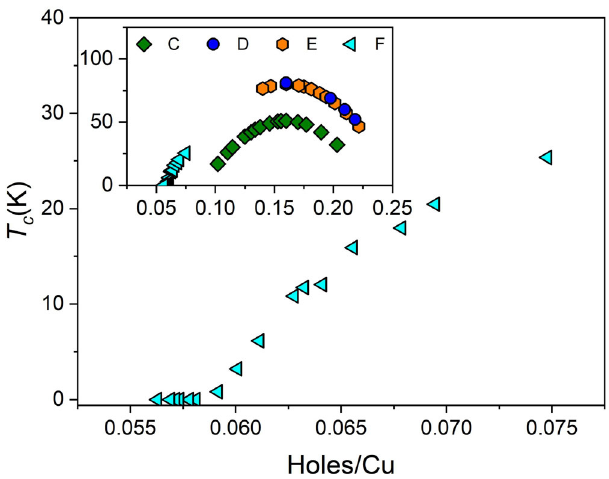
Fig. 3 Superconducting phase diagram. Superconducting dome as a function of critical temperature and doping. Inset: Superconducting phase diagram for four devices C, D, E, and F.